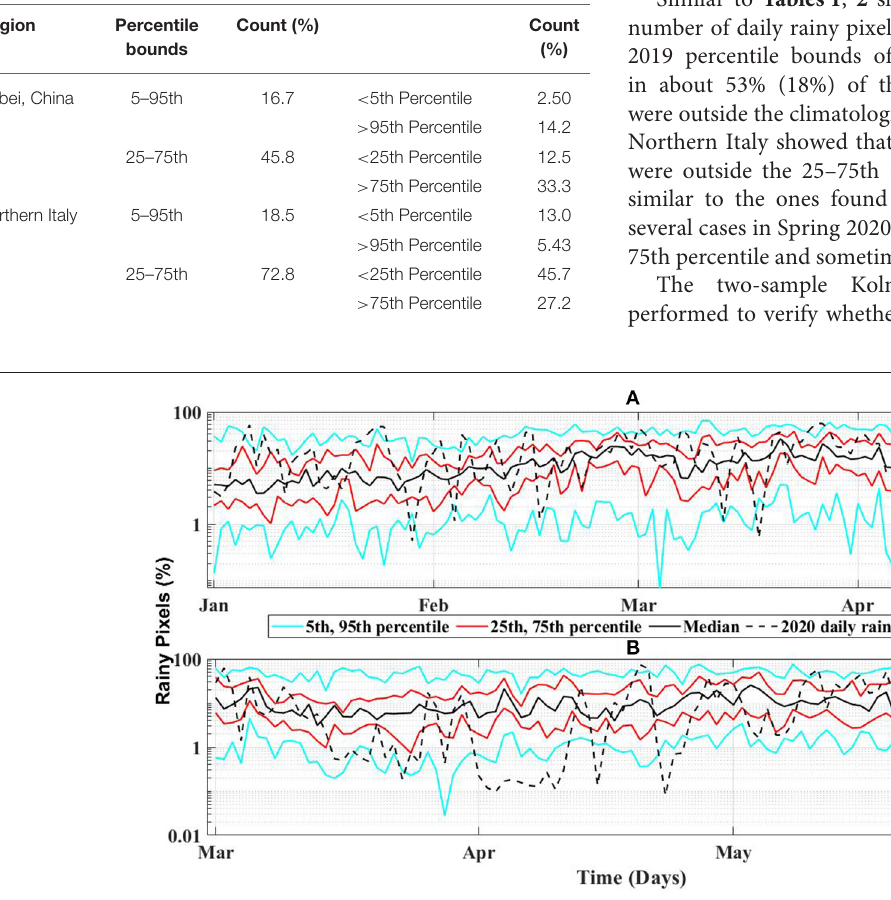
Frontiers in Climate |